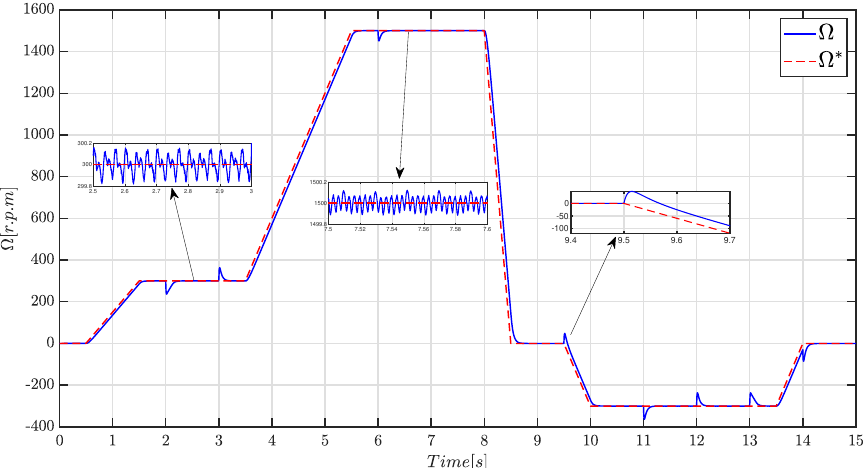
Figure 12. Velocity response obtained by PI controllers and optimal currents calculations